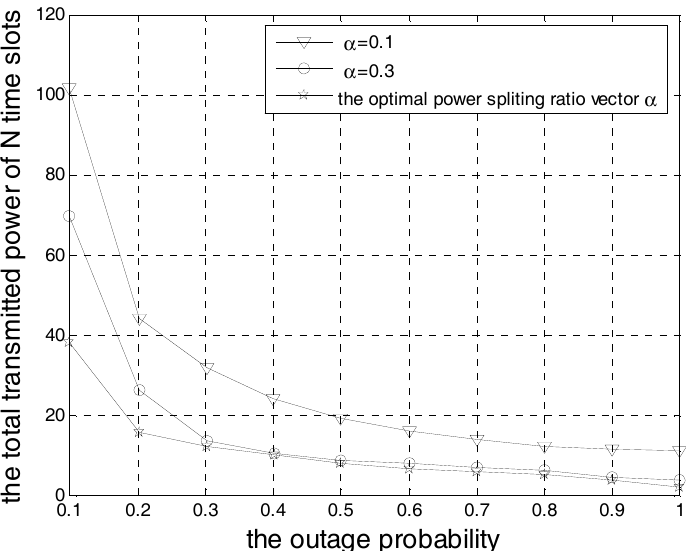
= σ 2 = 0.01 and 1, i 2, i